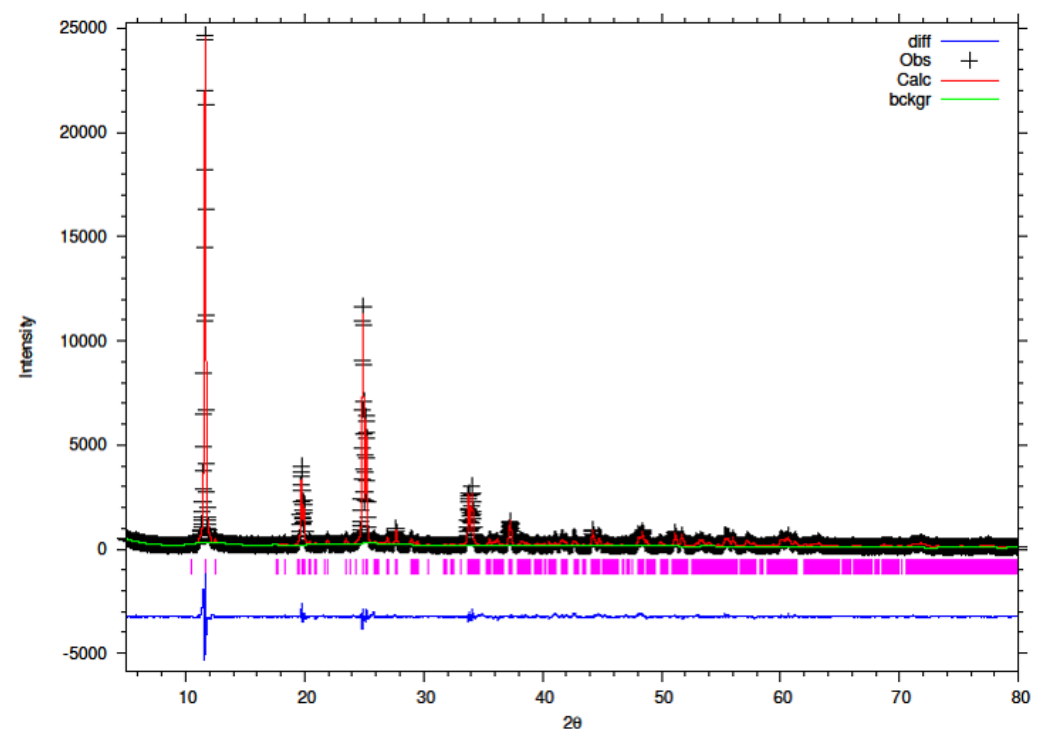
Figure 13. Final observed (cross), calculated (red line) and difference (blue bottom) Rietveld plots for hydrothermally synthesised 5% Y–ZrP. Table 8. Refined fractional atomic coordinates and isotropic thermal displacement parameters for hydrothermally synthesised 10% Y–ZrP.